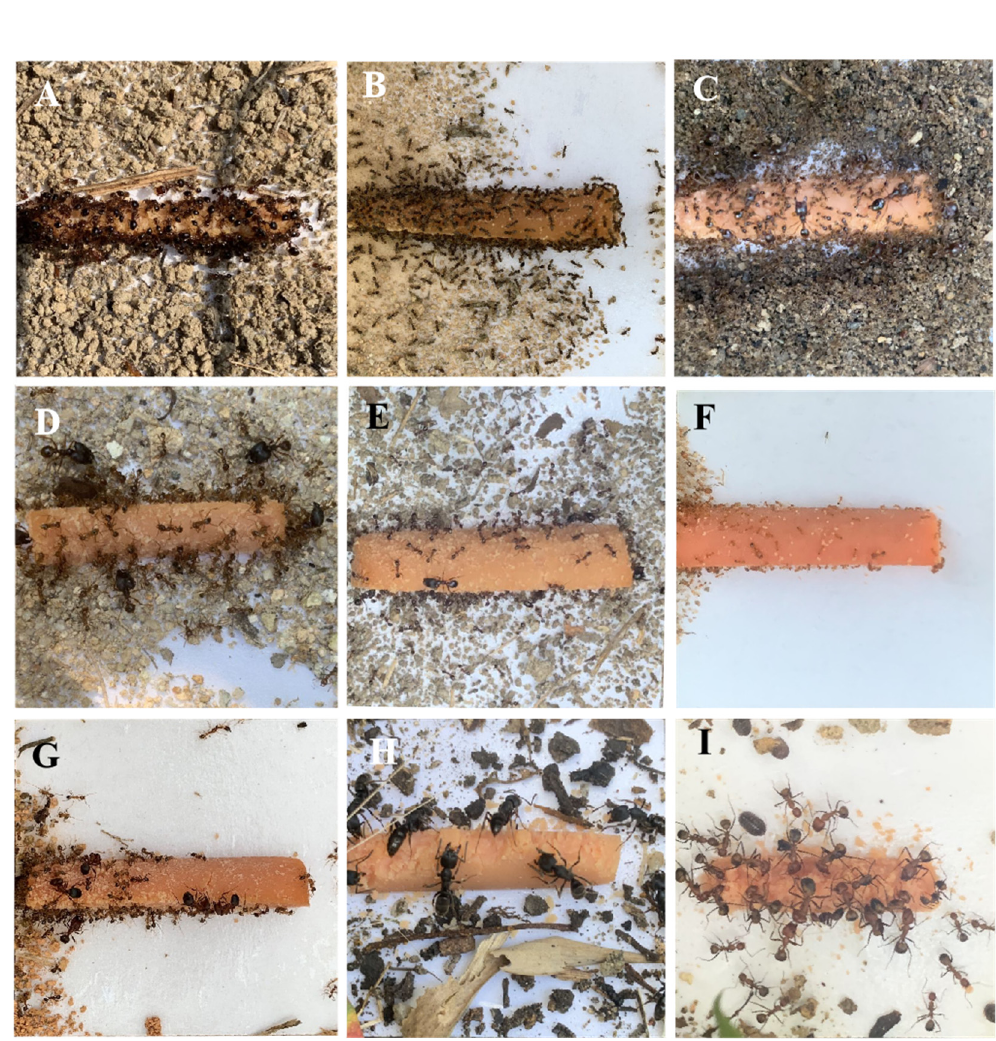
Figure 3. Example of adhesive tapes paved by Solenopsis invicta ( A ); Tapinoma melanocephalum ( B ); Carebara affinis ( C ); Pheidole sinica ( D ); Pheidole nodus ( E ); Pheidole parva ( F ); Pheidole yeensis ( G ); Odontoponera transversa ( H ); and Camponotus nicobarensis ( I ).